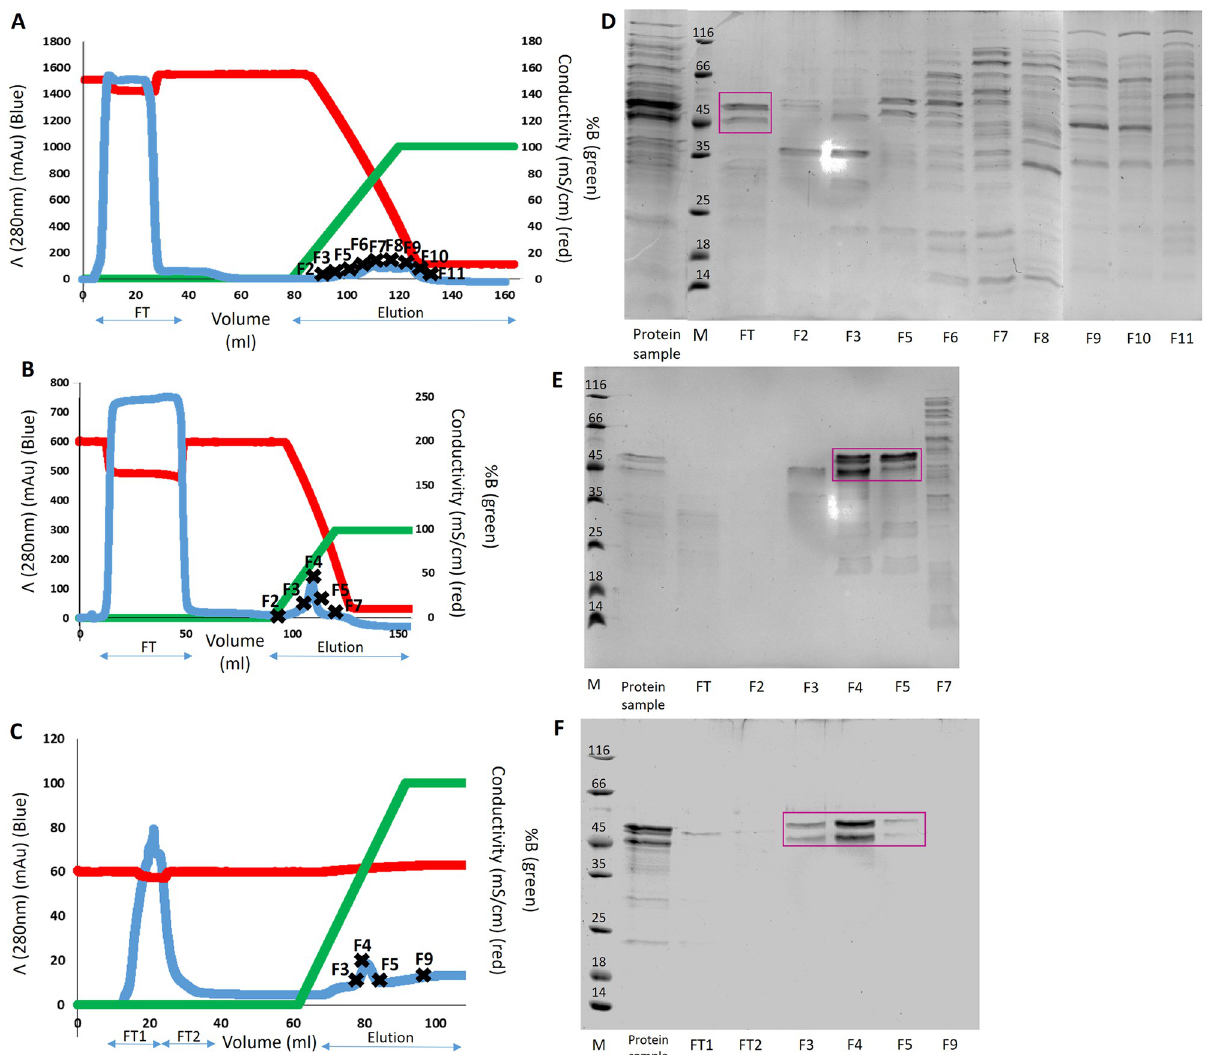
Fig 3. Three-part purification of the RBBP6-p53BD. Chromatograph with A280 effluent (blue), elution gradient (green), conductivity (red) and Flow-through (FT), elution and fractions collected (FX) depicted for (A) : Part 1, hydrophobic interaction chromatography with 1 M ammonium sulphate in binding buffer (B) : Part 2 hydrophobic interaction chromatography with 1.4 M ammonium sulphate in binding buffer and (C) : Part 3, nickel IMAC chromatography. SDS-PAGE analysis of protein sample loaded onto the column, the Flow-through (FT), and certain fractions collected "FX" where X represents the fraction number for (D) : Part 1, (E) : Part 2, and (F) : Part 3. The RBBP6-p53BD is indicated in flow-through (FT) or fractions (FX) with a pink box. The protein molecular weight marker (Thermo Scientific, 26610) has sizes in kDa, marked on the gel.